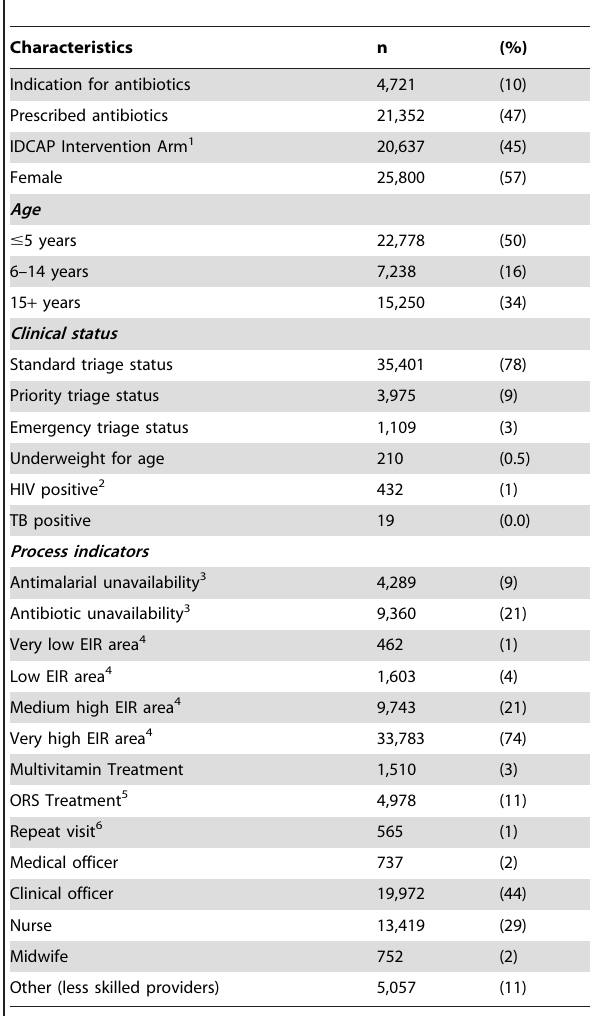
Table 1. Characteristics of 45,591 Malaria Positive Patient Visits in Ugandan